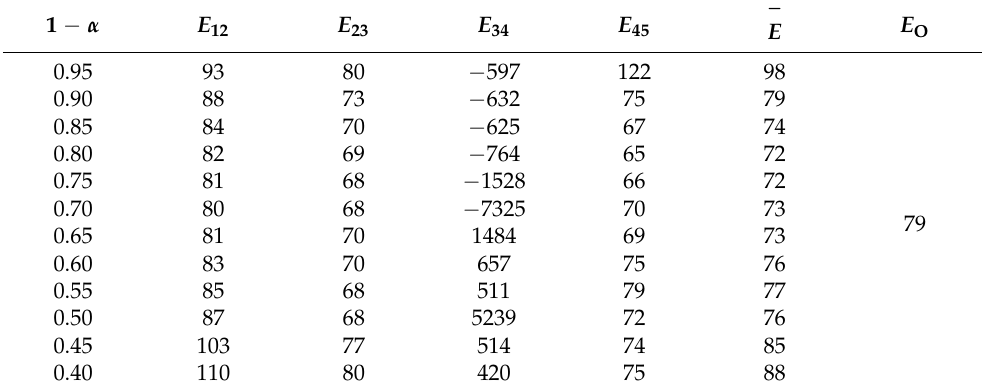
Table 1. The activation energy E O of urea decomposition (Unit: kJ/mol). 1 − α